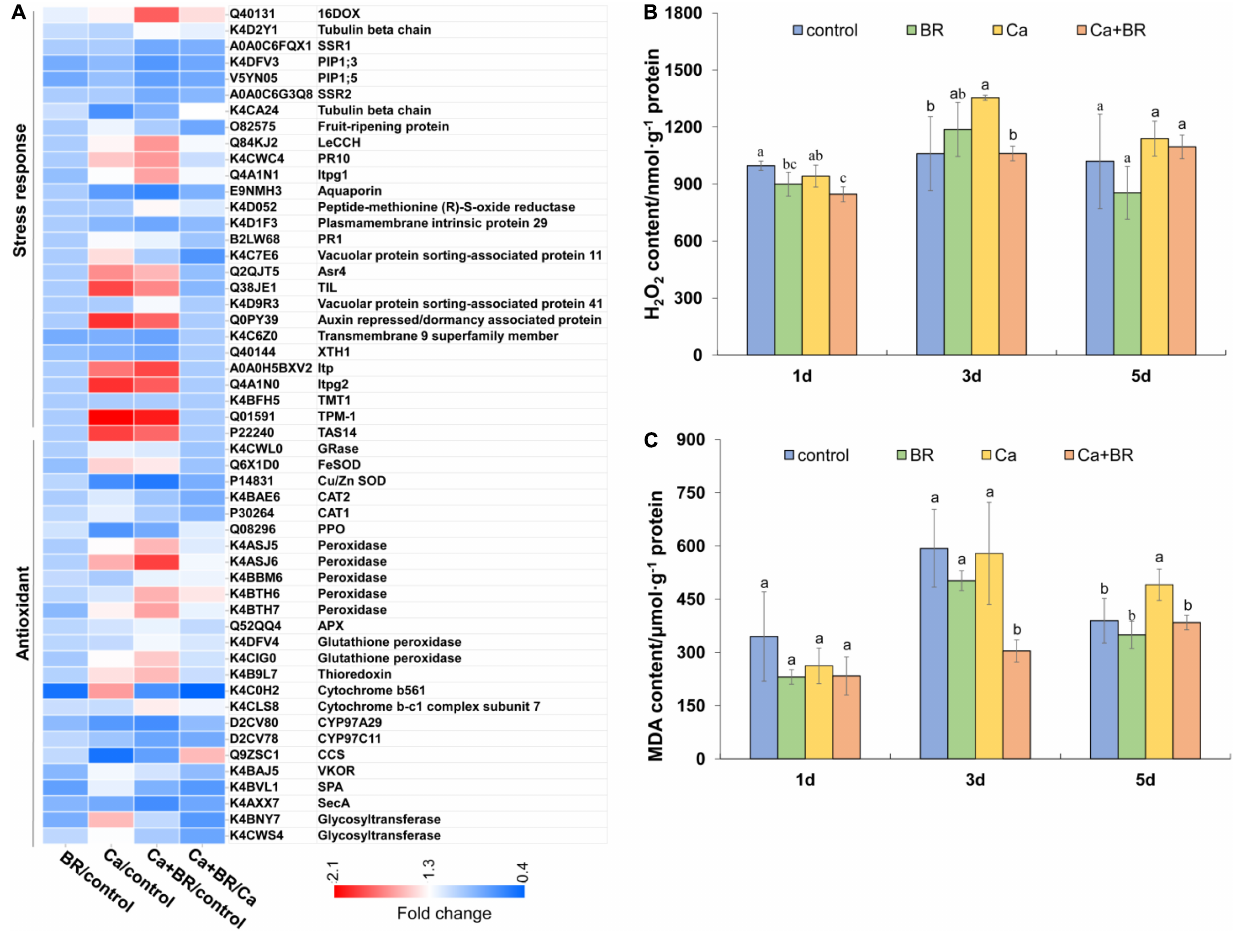
FIGURE 4 | The degree of membrane lipid peroxidation in the leaves of tomato seedling subjected to Ca(NO 3 ) 2 , foliar spraying with BR, or their combinations. (A) Heatmap of the differentially changed proteins involved in the antioxidant system. (B) Hydrogen peroxide (H 2 O 2 ) content. (C) Malondialdehyde (MDA) content. BR, 0.1 µ mol/L brassinolide; Ca, 100 mmol/L Ca(NO 3 ) 2 ; Ca+BR, 100 mmol/L Ca(NO 3 ) 2 stress plus foliar spraying with exogenous BR. Each data point represents the mean of three independent biological replicates (mean ± SD). Different letters above the bars indicate statistically significant differences ( P <